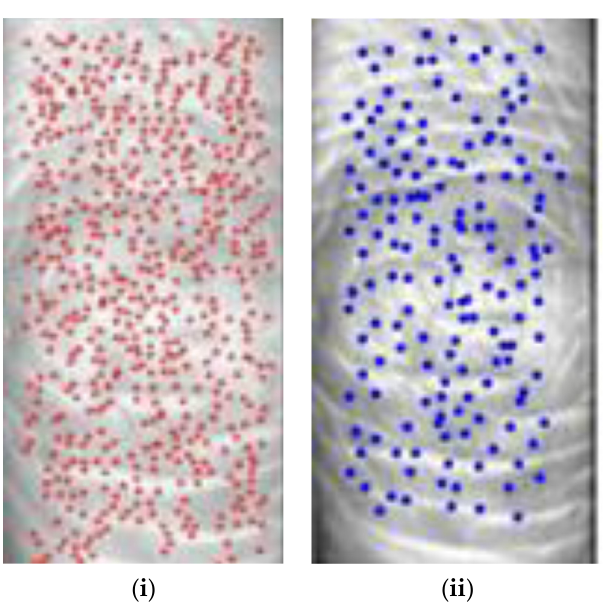
Figure 5. ( i ) SIFT key points ( ii ) SURF key points .